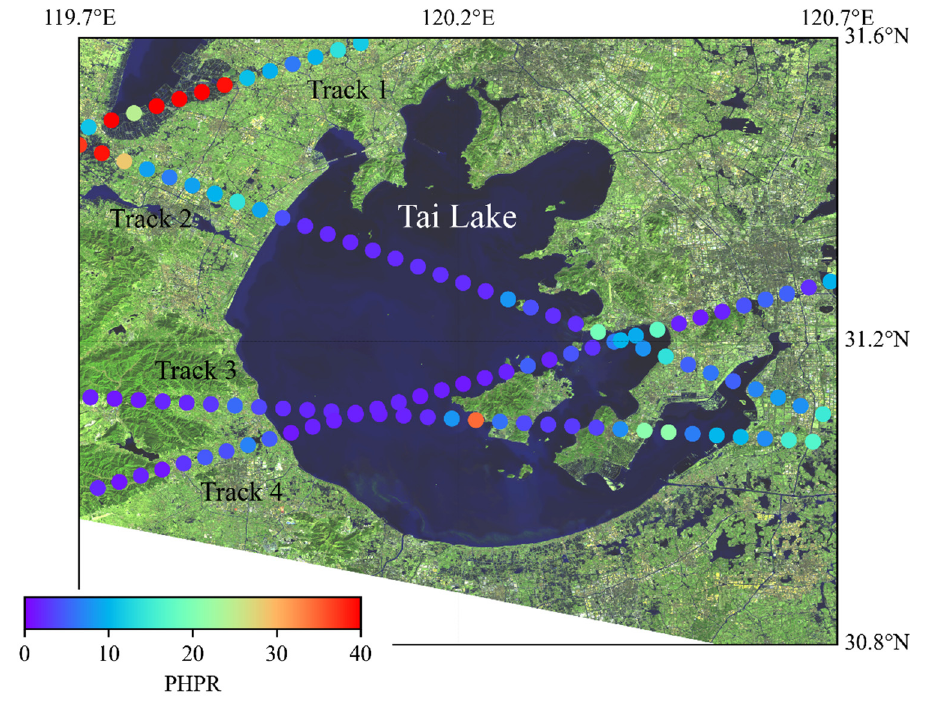
Figure 12. Tracks of the CYGNSS specular reflection points in the Tai Lake area in China on 26 February 2020 with the numbers marked. The corresponding PHPR values are indicated by the color bar. The background image is a fusion of bands 7, 6, and 4 from the image acquired by Landsat 9 on the same day.